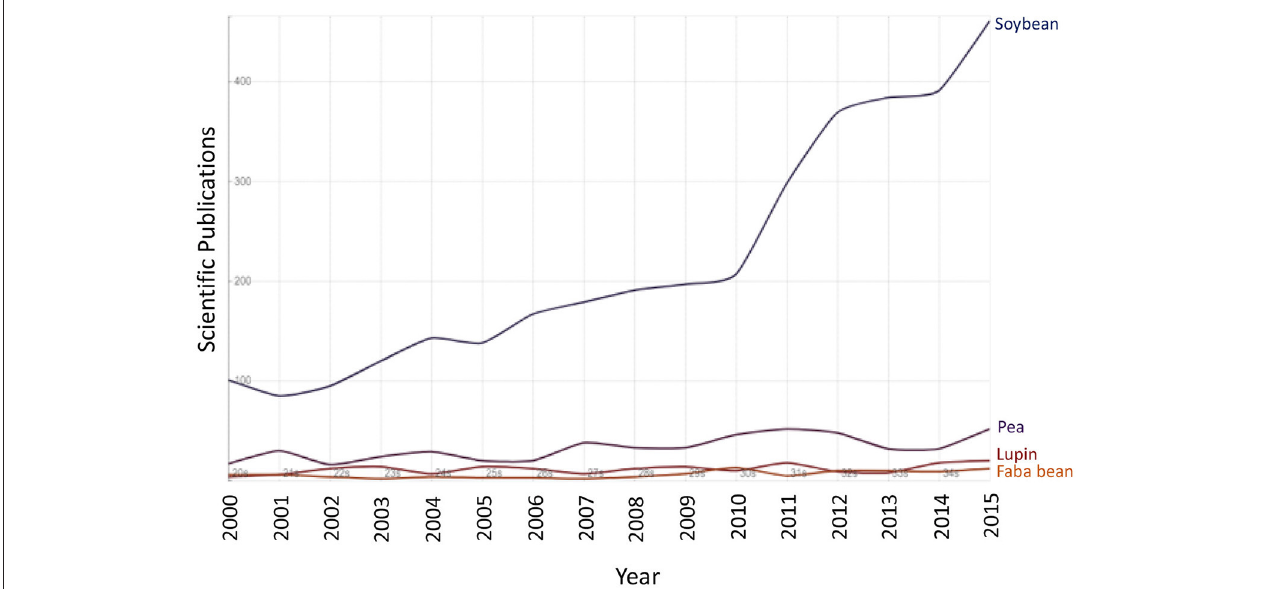
FIGURE 4 | Scientific publications on soybean, pea, fava, and lupin in food sciences, published between 2000 and 2015 and registered on the Web of Science (WoS, Clarivate Analytics) This graph has been created by the authors based on specific search queries of various key words for the main topics of food science (excluding oil use), restricted to those species. The search query was done on titles, abstracts, and key words among the articles registered on the Web of Science (WoS, Clarivate Analytics) between 2000 and 2015. These results come from a larger bibliometric study in progress by the authors. The search query is available on request.